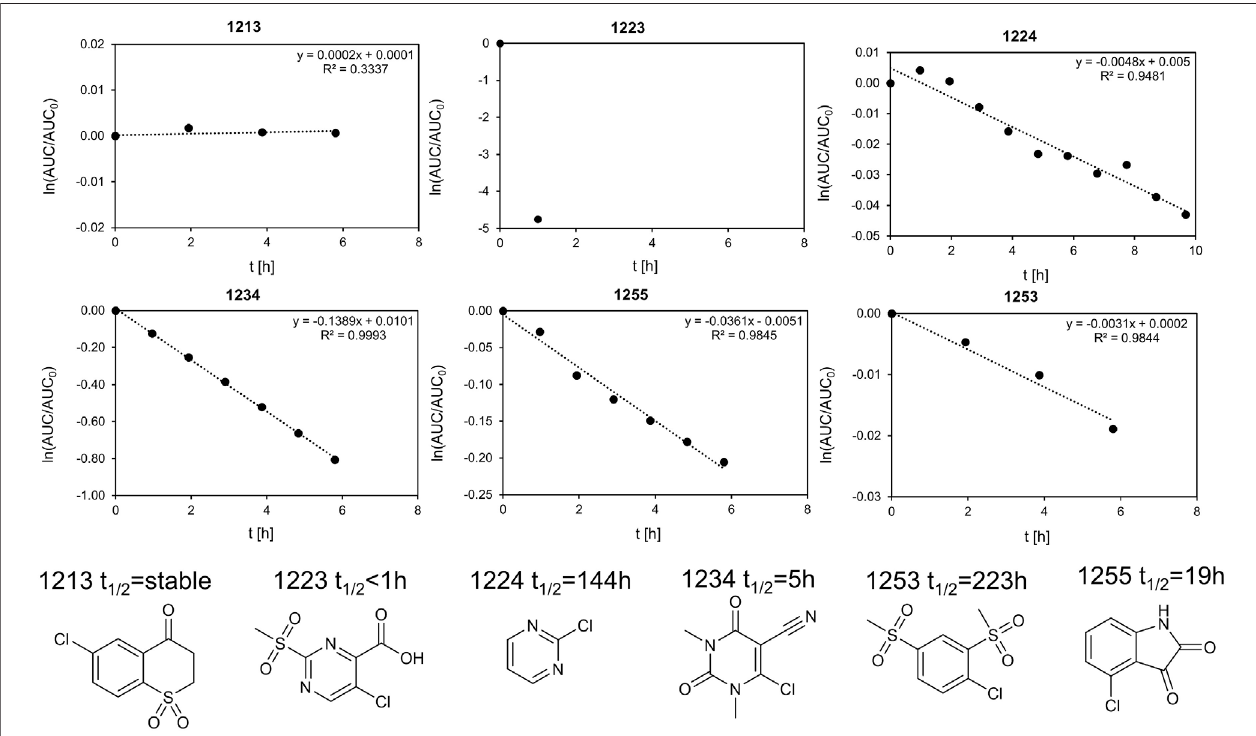
FIGURE5| Stabilityassayfor1255and1234withGSH.ThelinearizedfunctionoftheAUCoftheHPLCpeakisplottedagainstthetime.Theextrapolatedhalf-lifeis 19.2 and 5 h, respectively. We de fi ne half-lifes t 1/2 > 20 h as suf fi ciently stable for fragment screening. As the half-life was measured at 40 ° C and the screening as 20 ° C, thestabilityoffragmentswitht 1/2 > 20 hshouldbesuf fi cient.Ofthesixfragmentsshown,thetoprow(fragments1223,1234,and1255)isunstable,whereasthebottom row (fragments 1224, 1213, and 1253) was considered stable within our de fi nition.